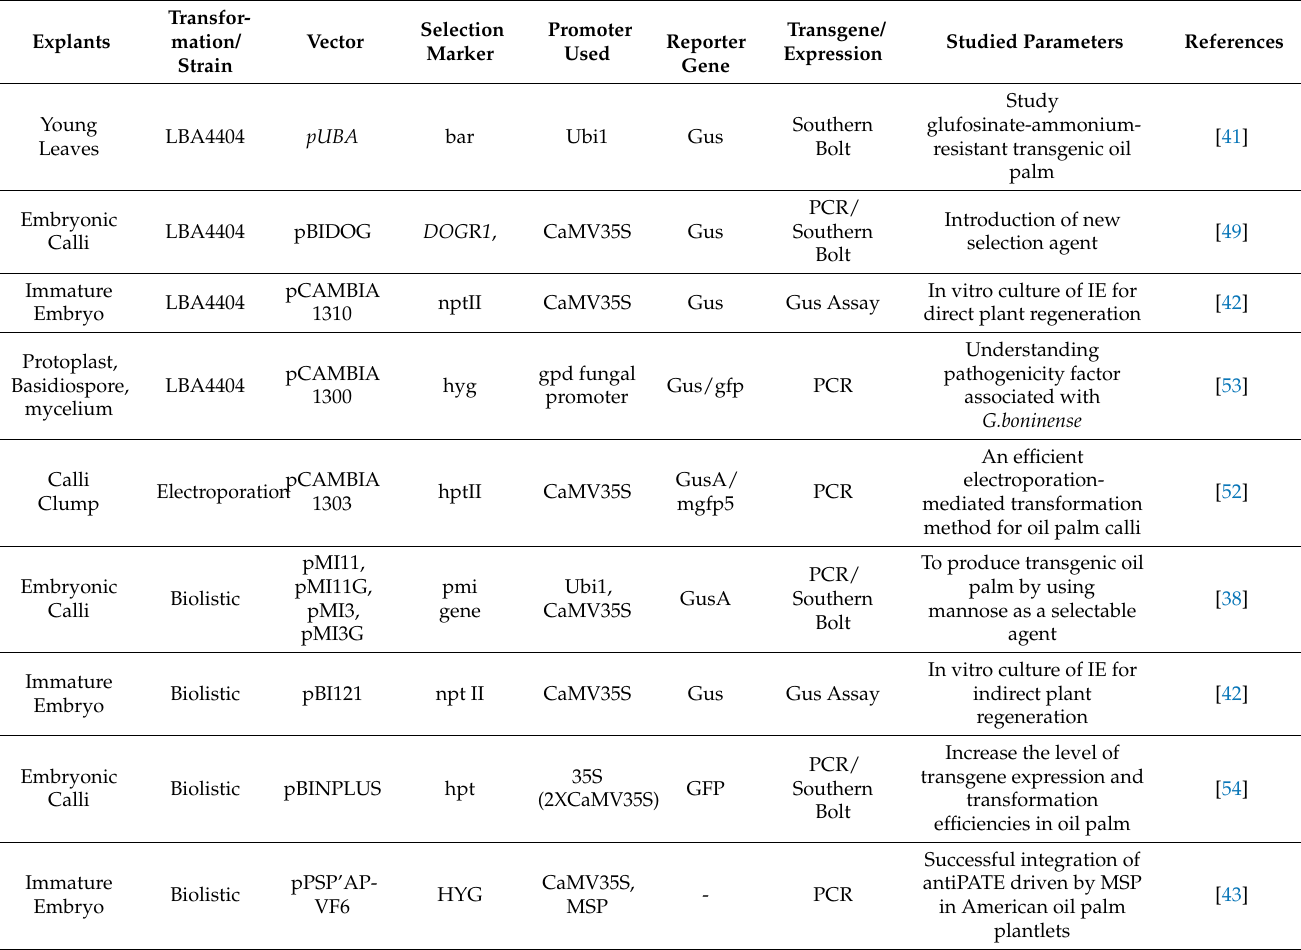
Table 1. Genetic transformation of oil palm through Agrobacterium -mediated transformation and direct DNA transfer